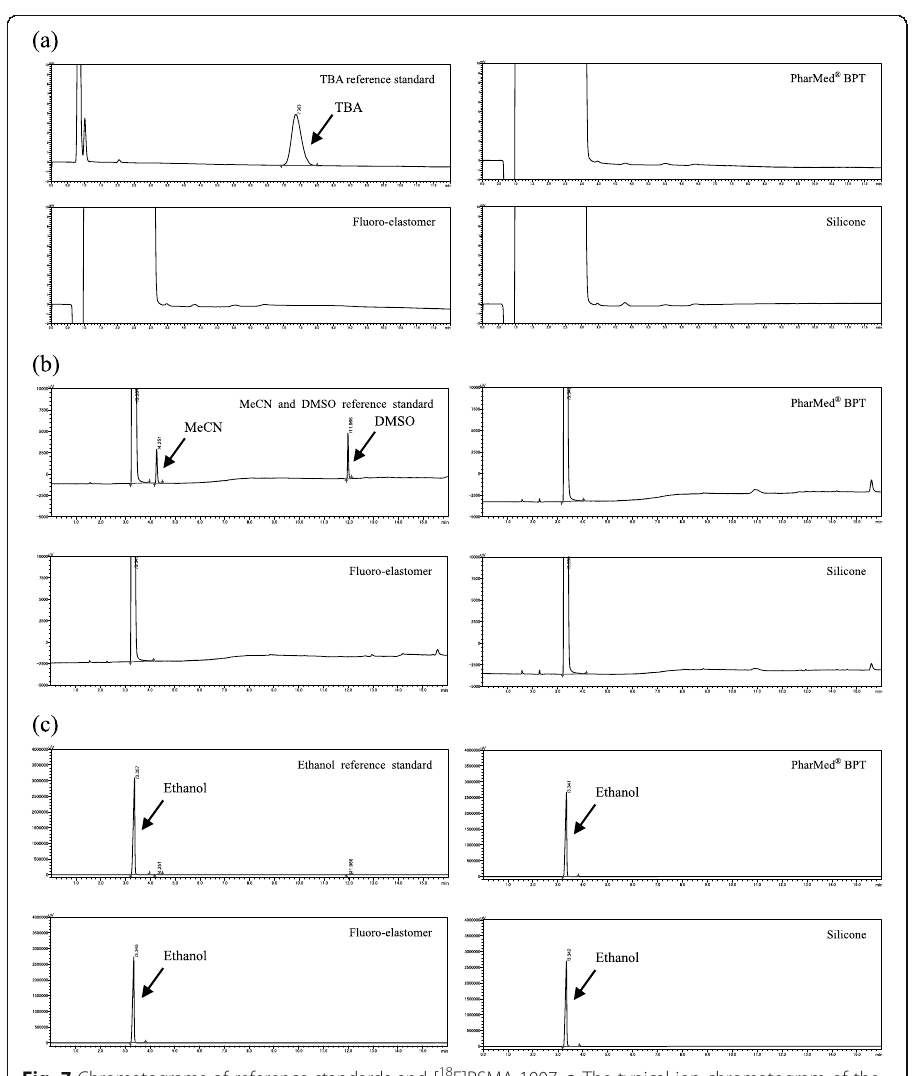
Fig. 7 Chromatograms of reference standards and [ 18 F]PSMA-1007. a The typical ion-chromatogram of the tetrabutylammonium (TBA) reference standard and [ 18 F]PSMA-1007 solution produced using cassettes with three types of tubing material with the TFA salt precursor. The TBA reference standard was 260 μ g/mL (RT 7.363 min). The TBA peak of [ 18 F]PSMA-1007 solution was not detected. The lower limit of the